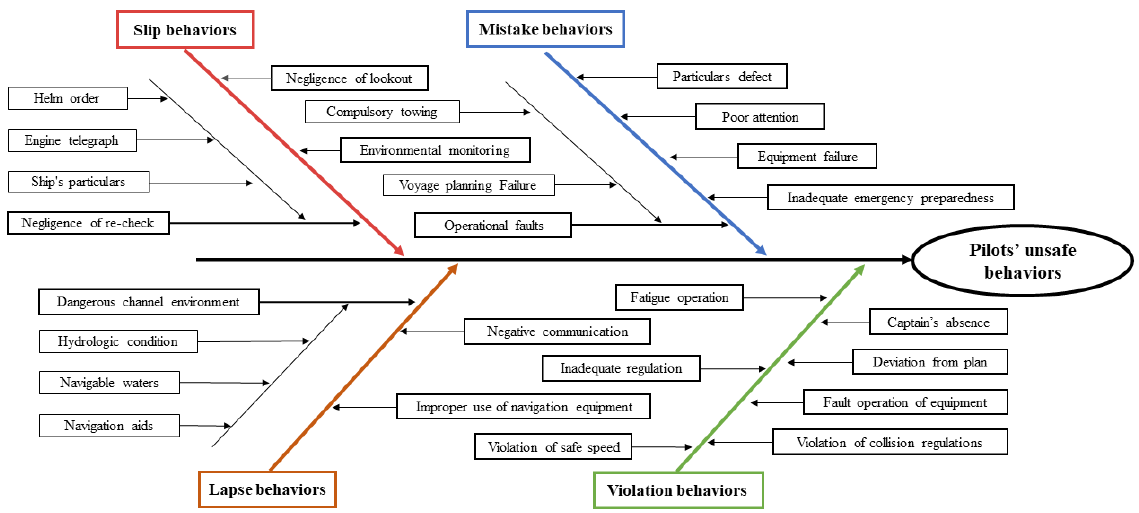
Figure 3. Pilots’ unsafe behaviors hierarchical classification framework.